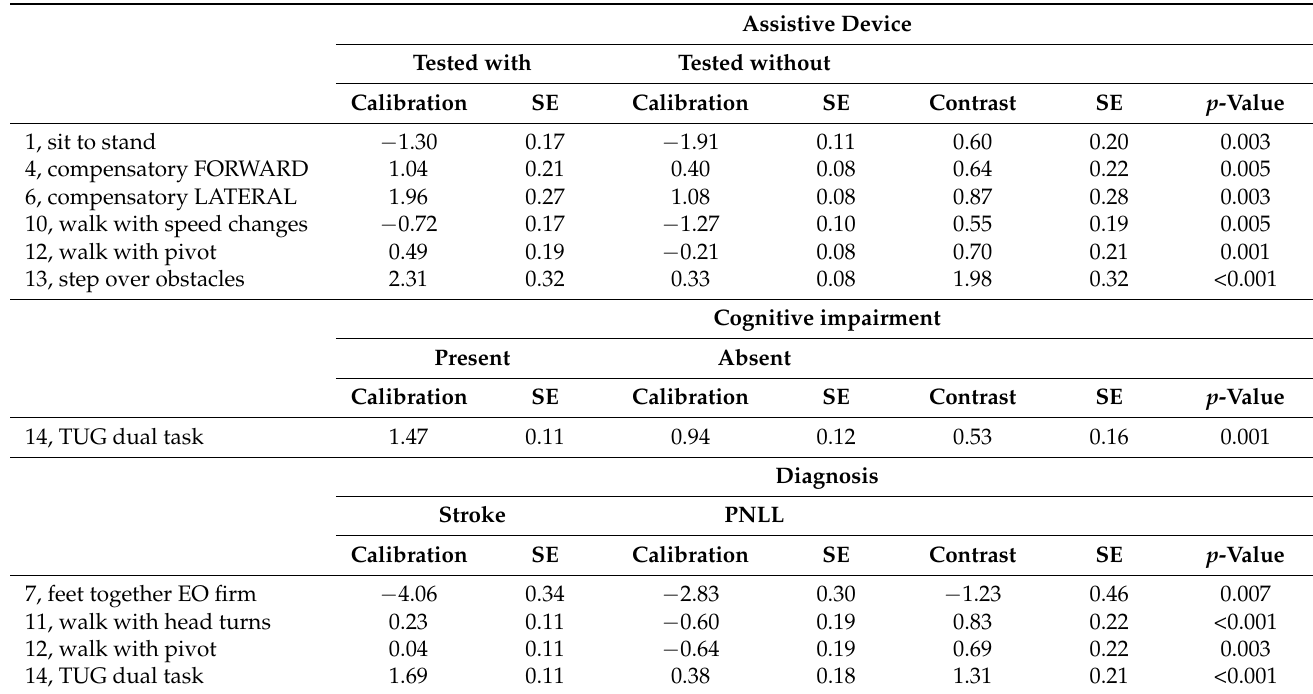
Table 4. Differential Item Functioning of the Mini-BESTest